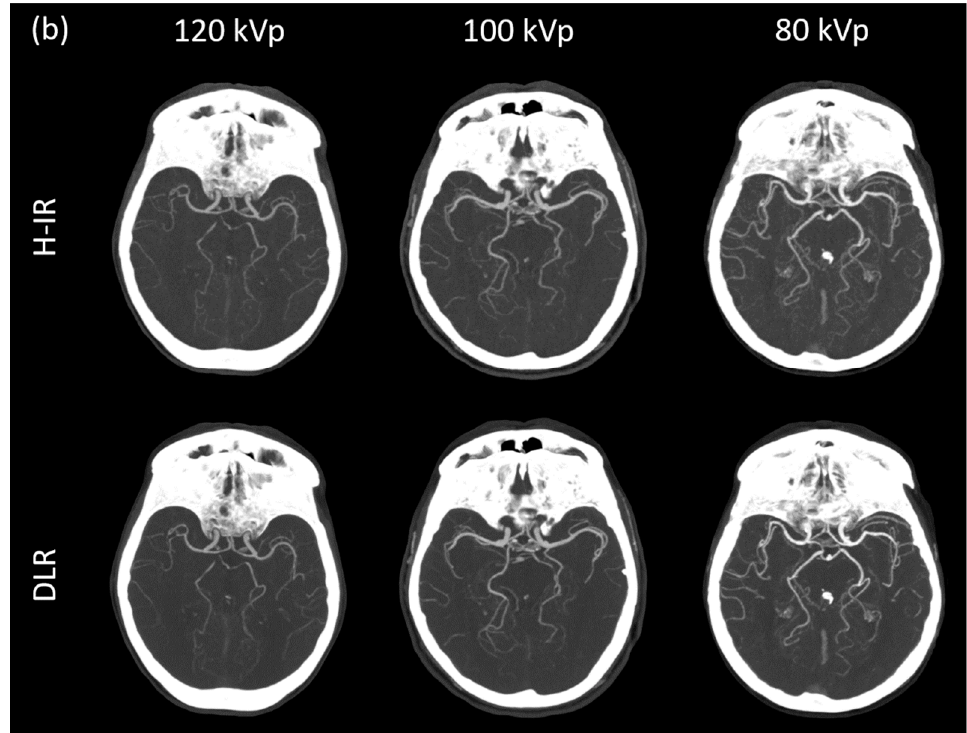
Figure 3. ( a ) Curved planar reconstructed CT image, ( b ) Axial MIP 20mm of patients from each group for both DLR (AiCE) and H-IR (AIDR 3D) reconstructions with a constant window setting (W:1000 L:300). 120 kVp patient was a 68-year-old woman (BMI: 25.7), CTDI 4.7 mGy, DLP 196.8 mGy ·